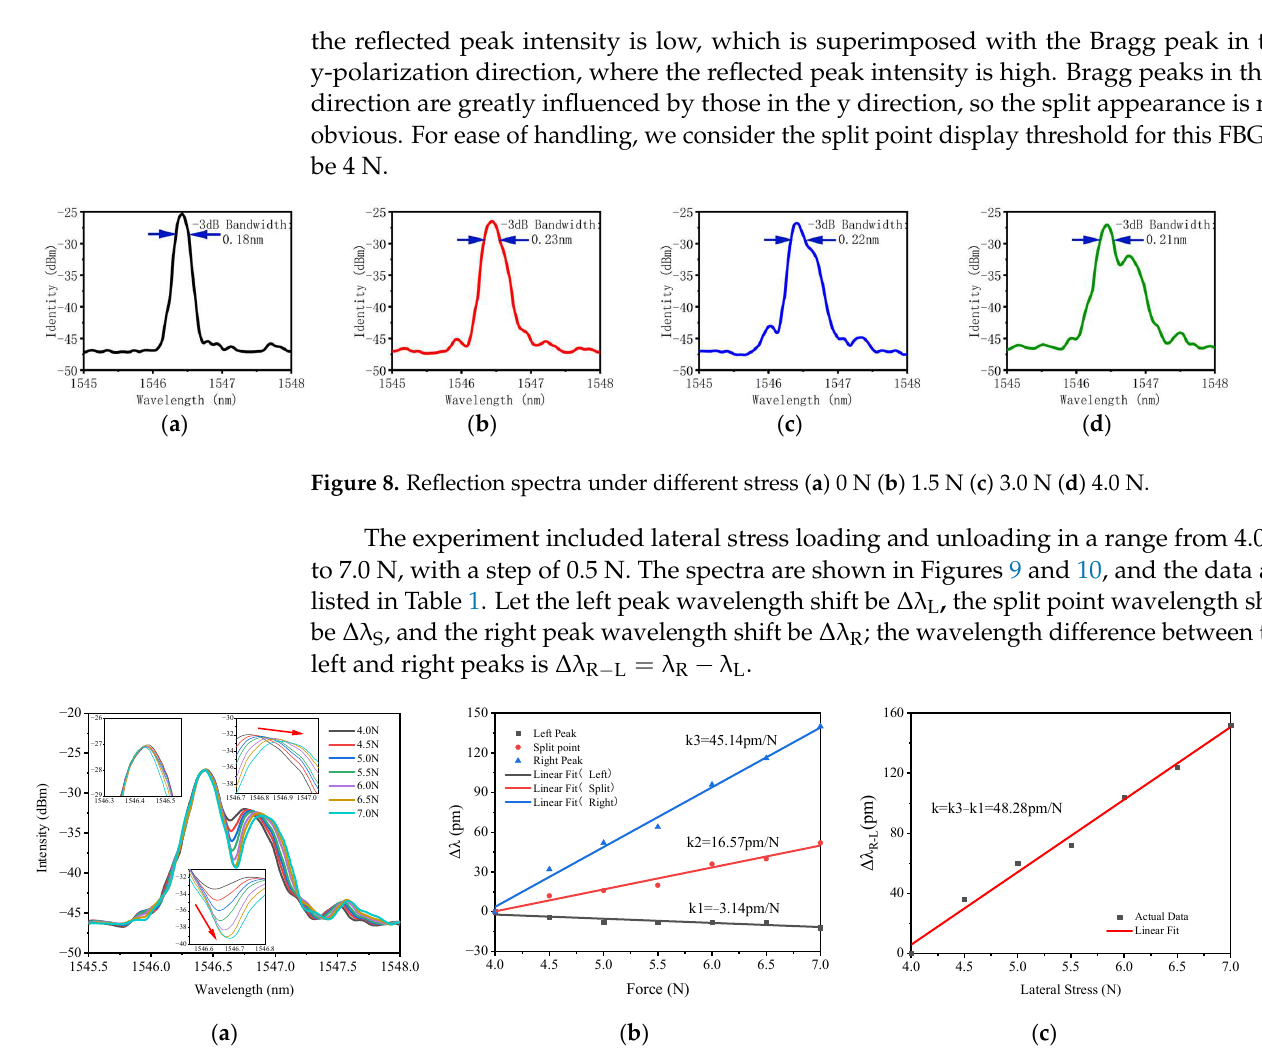
 , L  under different load pressures. R L  ∆ λ R − L under different load pressures.